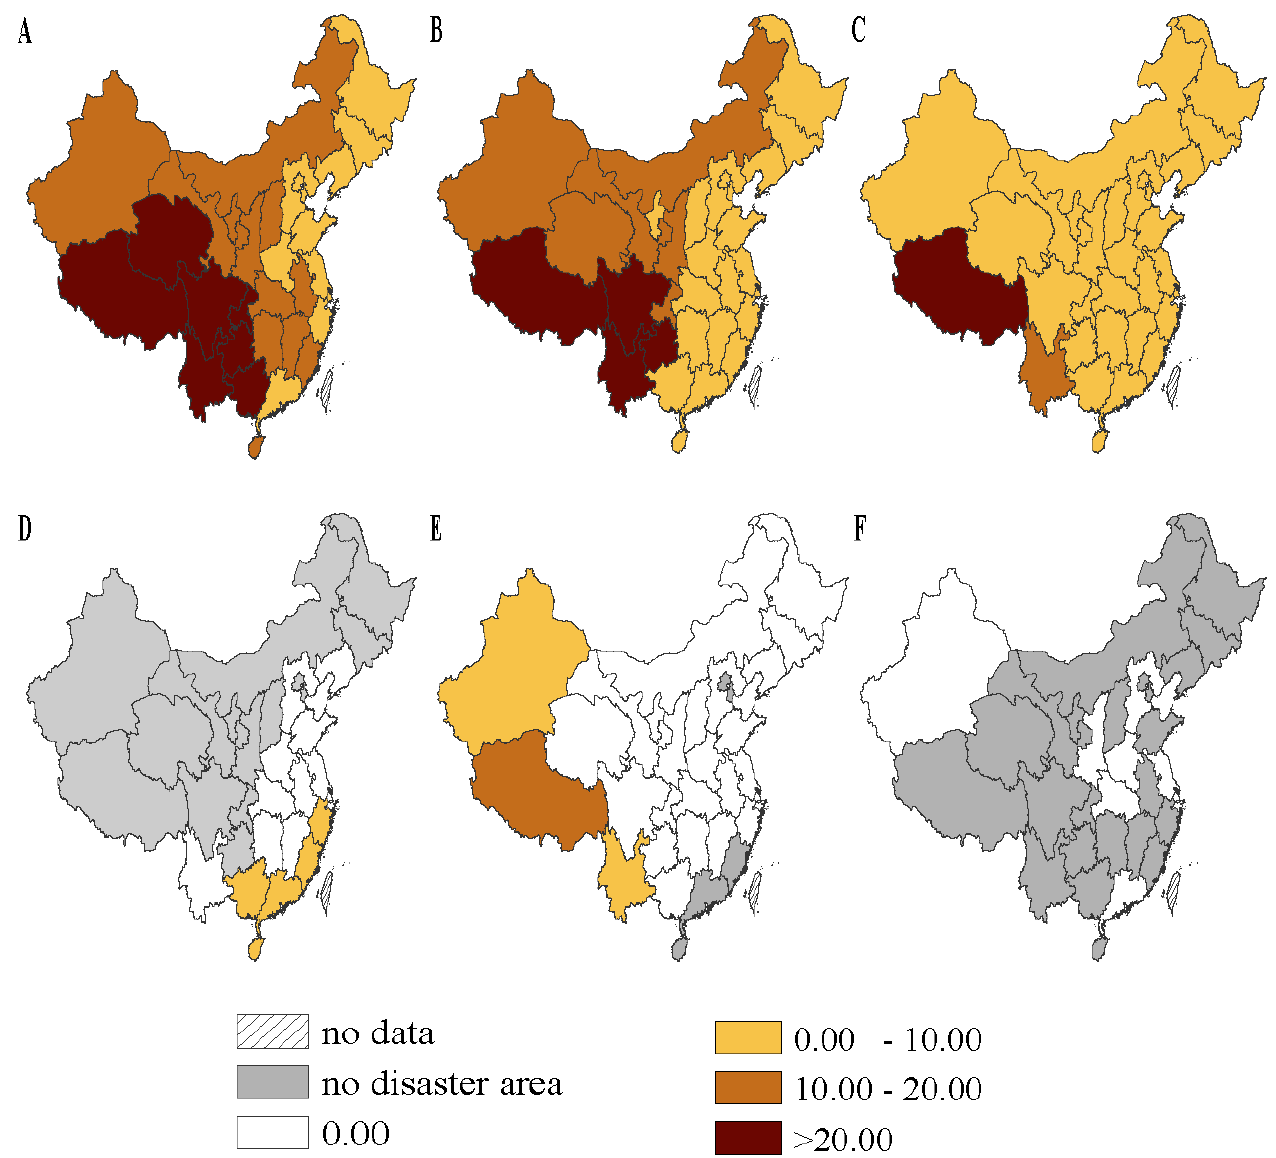
Figure 4. Mean mortality (/10,000,000) caused by meteorological disasters at provincial level, 2004– 2015: ( A ). All. ( B ). Floods. ( C ). Hail. ( D ). Typhoon. ( E ). Snow. ( F ). Heatwave. Note. ArcGIS 10.2